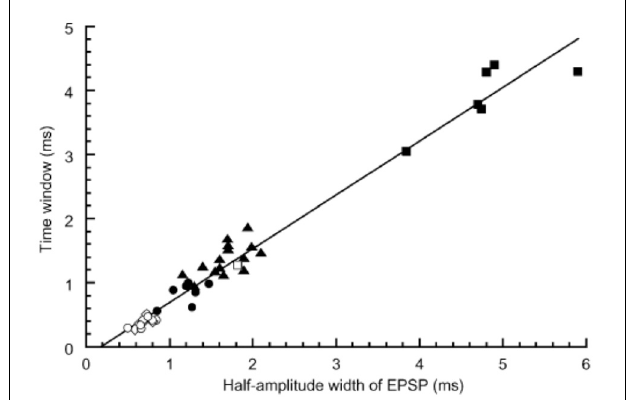
FIGURE 3 | Correlation between the time window for coincidence detection and the width of EPSP measured in the NL neurons. Time windows were plotted against the half amplitude width of EPSP recorded at − 62mV. Different symbols indicate different experimental conditions: (cid:2) , embryo recorded at 20–25 ◦ C ( n = 6); (cid:3) , embryo 40 ◦ C ( n = 1); (cid:4) , chick 20–25 ◦ C ( n = 15); (cid:2) , chick 30 ◦ C ( n = 7); (cid:3) , chick 40 ◦ C ( n = 8); 40 ◦ C without bicuculline using low-Cl internal solution ( n = 5). Reproduced with permission from Kuba et al.